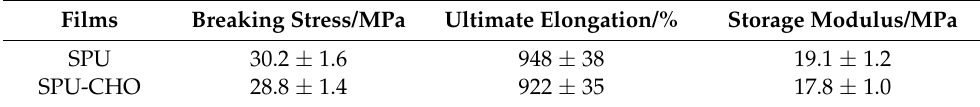
Figure 3. Typical stress vs. strain curves for SPU and SPU-CHO films. Table 1. Tensile properties of SPU and SPU-CHO films ( n =